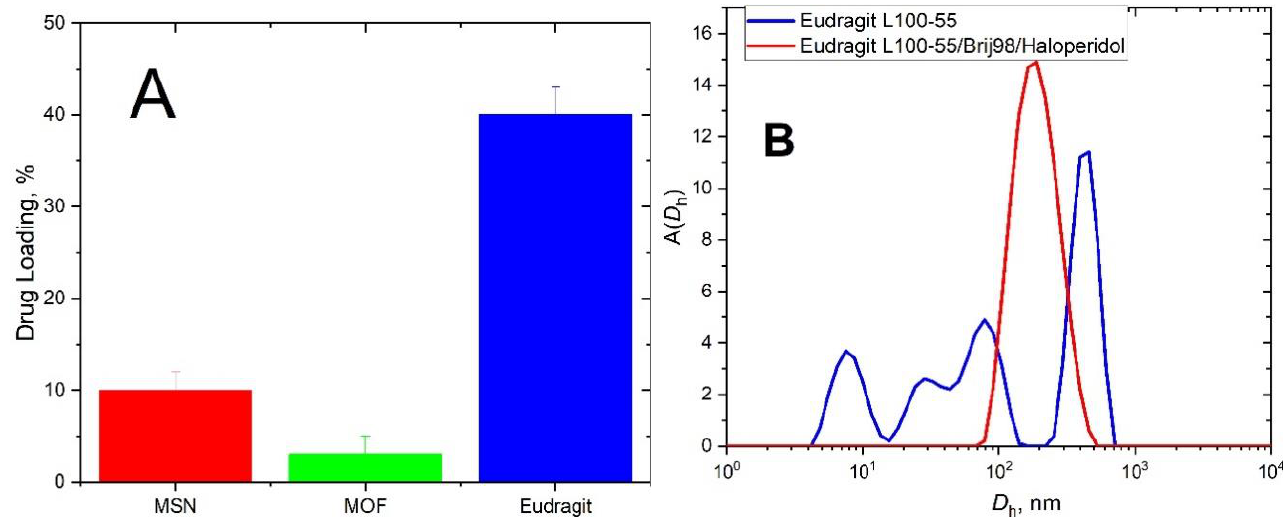
Figure 2. ( A ) Drug loading into MOF, MSN, and hybrid Eudragit/Brij98 nanoparticles. ( B ) The intensity-weighted distribution functions over hydrodynamic diameter D h for unloaded at pH = 11 and haloperidol-loaded Eudragit 100-55/Brij98 nanoparticles at pH = 3.